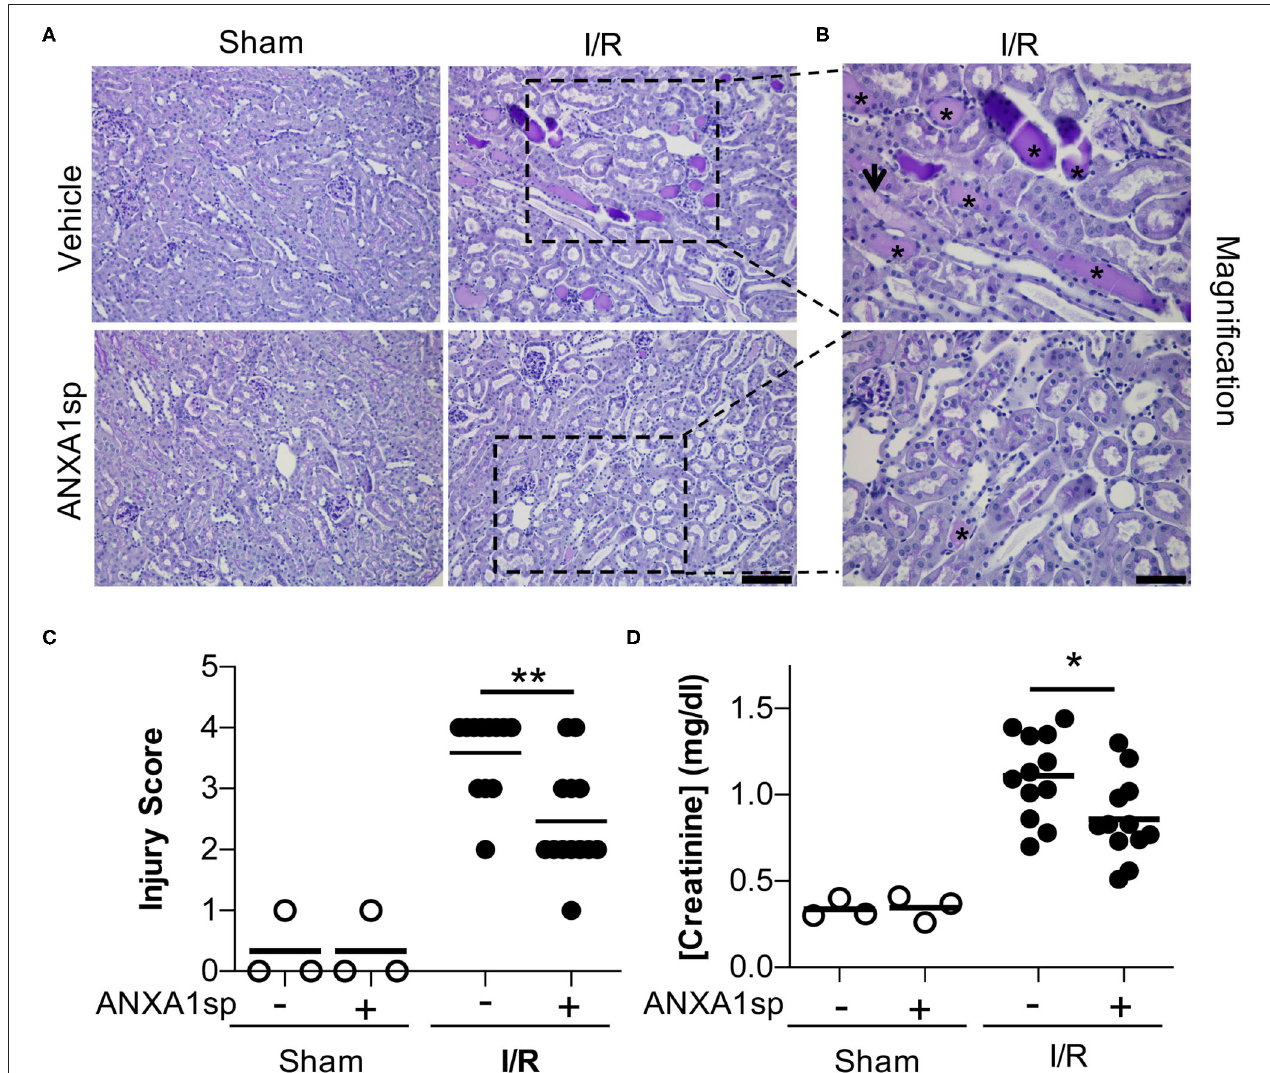
FIGURE 1 | AnnexinA1 tripeptide (ANXA1sp) attenuates kidney injury following ischemia/reperfusion-induced kidney injury. Mice were treated with either Vehicle or ANXA1sp and subjected to 33min of unilateral ischemia and contralateral nephrectomy and then re-injected with Vehicle or ANXA1sp 1h after reperfusion. (A) Representative periodic-acid Schiff (PAS)-stained kidney sections demonstrating increased injury in Vehicle, I/R group at Day 1 after ischemia ( scale bar = 100 um). (B) Increased magnification of boxes in (A) to demonstrate increased histologic evidence of injury in Vehicle, I/R mice (asterisk: protein casts; arrowhead: tubule vacuolization) compared to ANXA1sp-treated mice ( scale bar = 50 um). (C) Histologic injury scoring from (A) by observer blinded to experimental grouping ( n = 3 for Sham groups, n = 12 for I/R groups). ANXA1sp-treated mice display attenuated kidney injury. Statistical significance determined by two-way ANOVA with